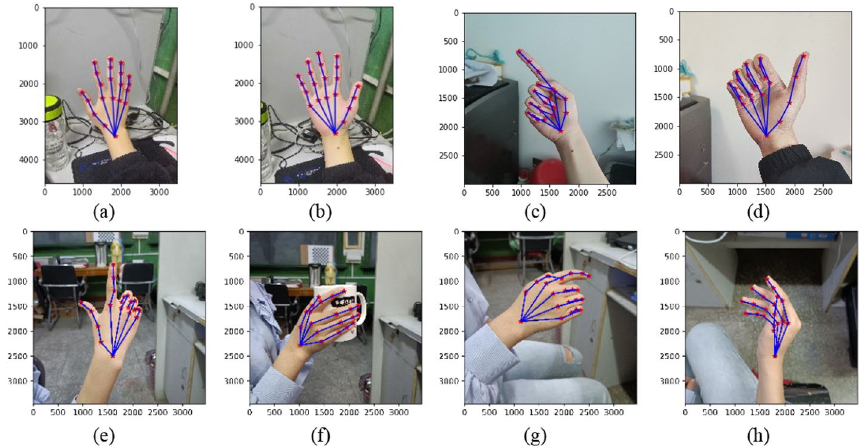
Fig. 11 Test results in real-world